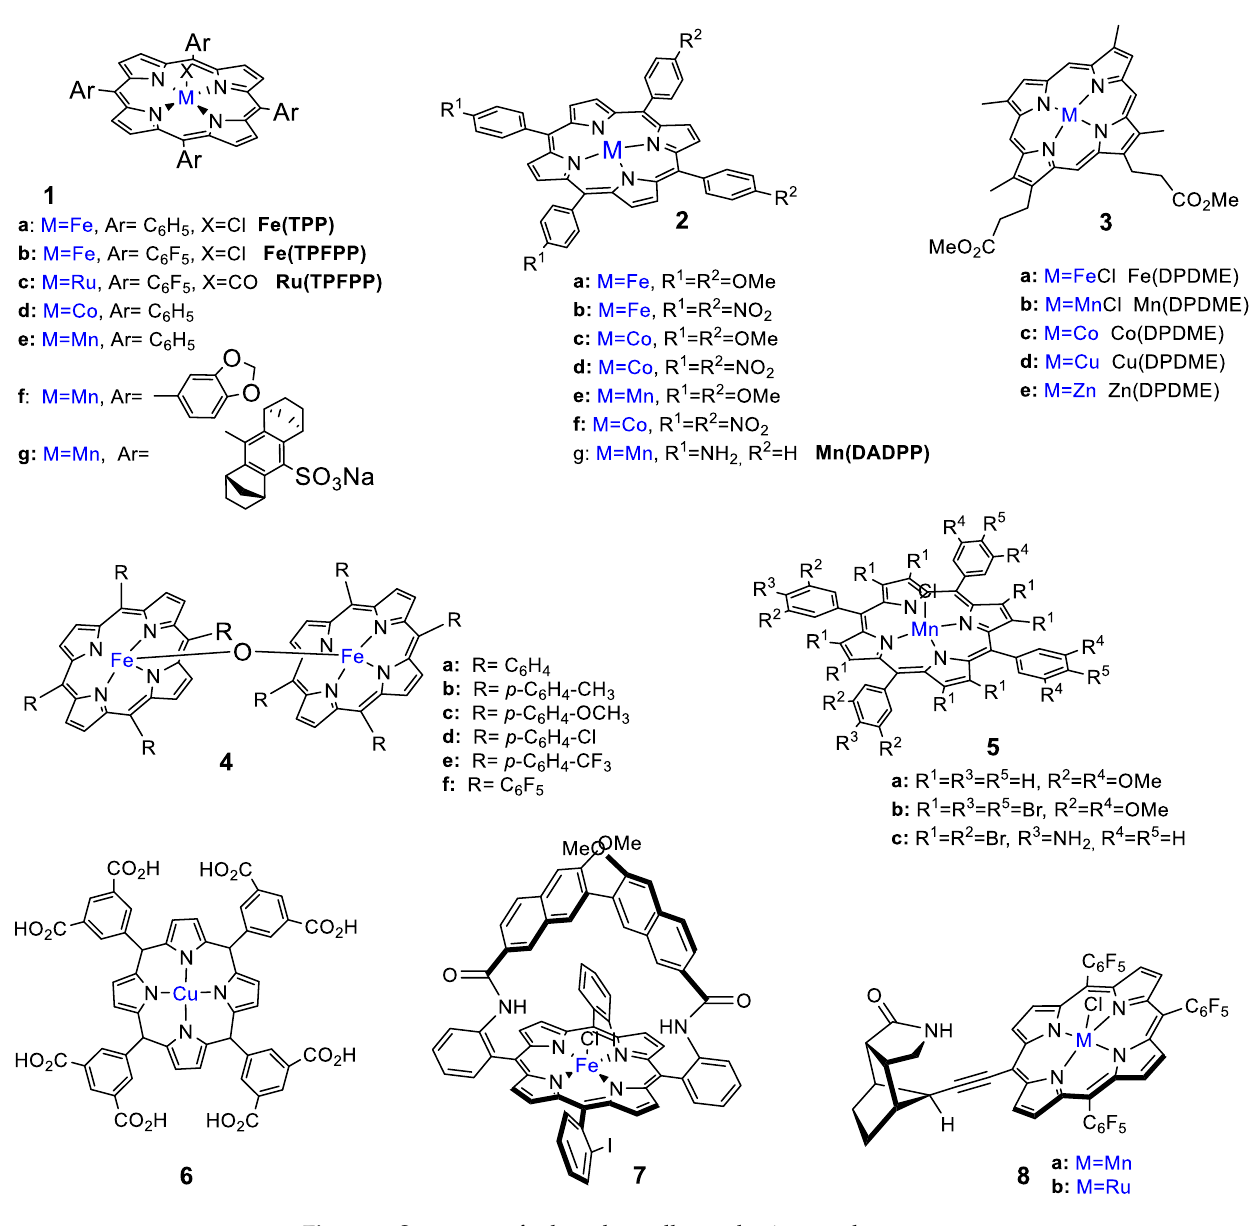
Figure 1. Structures of selected metalloporphyrin complexes.